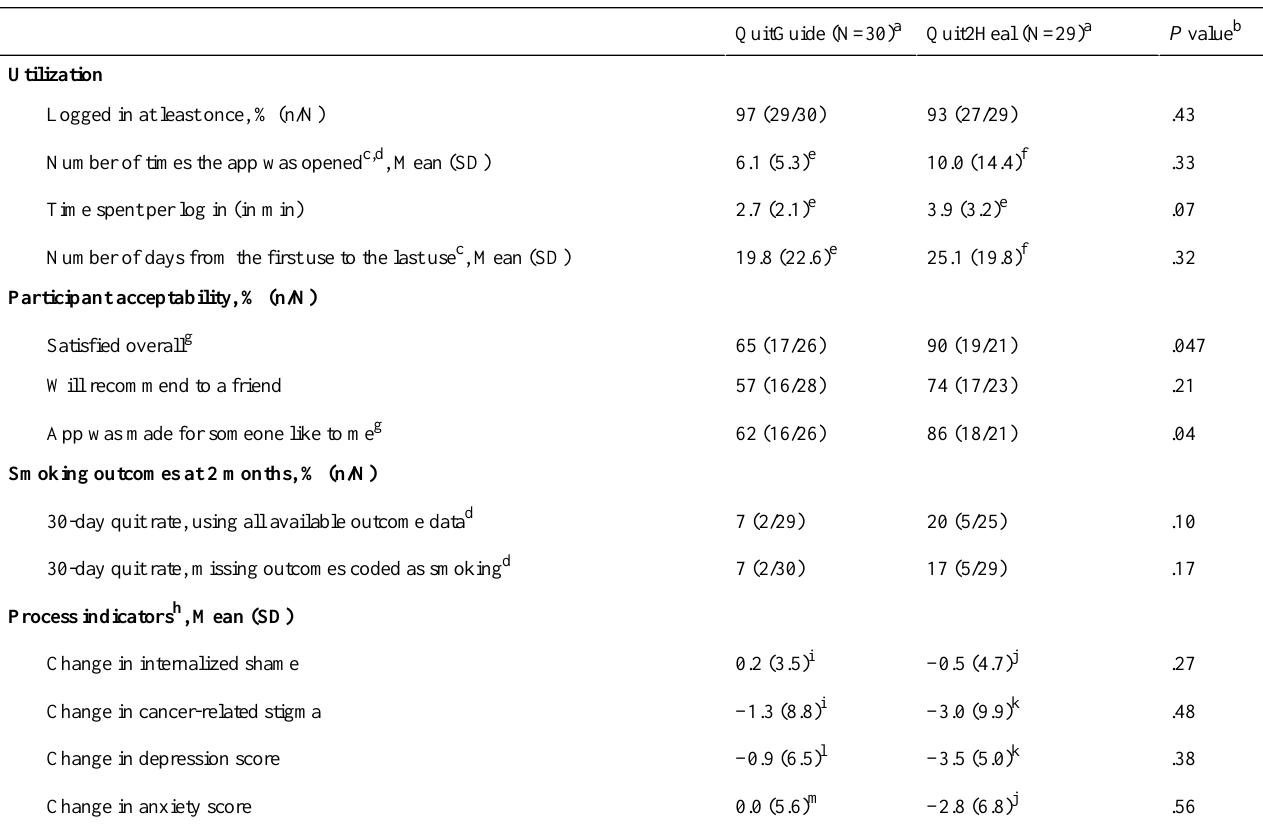
Table 2. Primary and secondary study